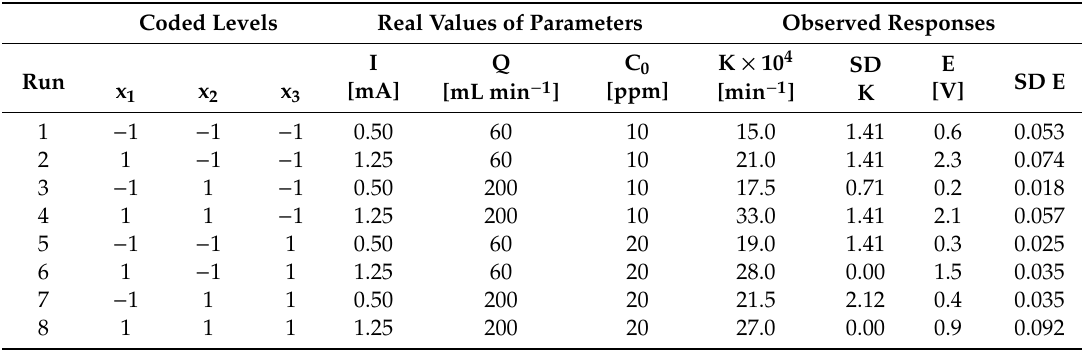
Table 1. Values of the K and E measured in the eight runs of the DoE. Averaged values and the related standard deviation (SD) are evaluated for data repeated twice. Coded Levels Real Values of Parameters Observed